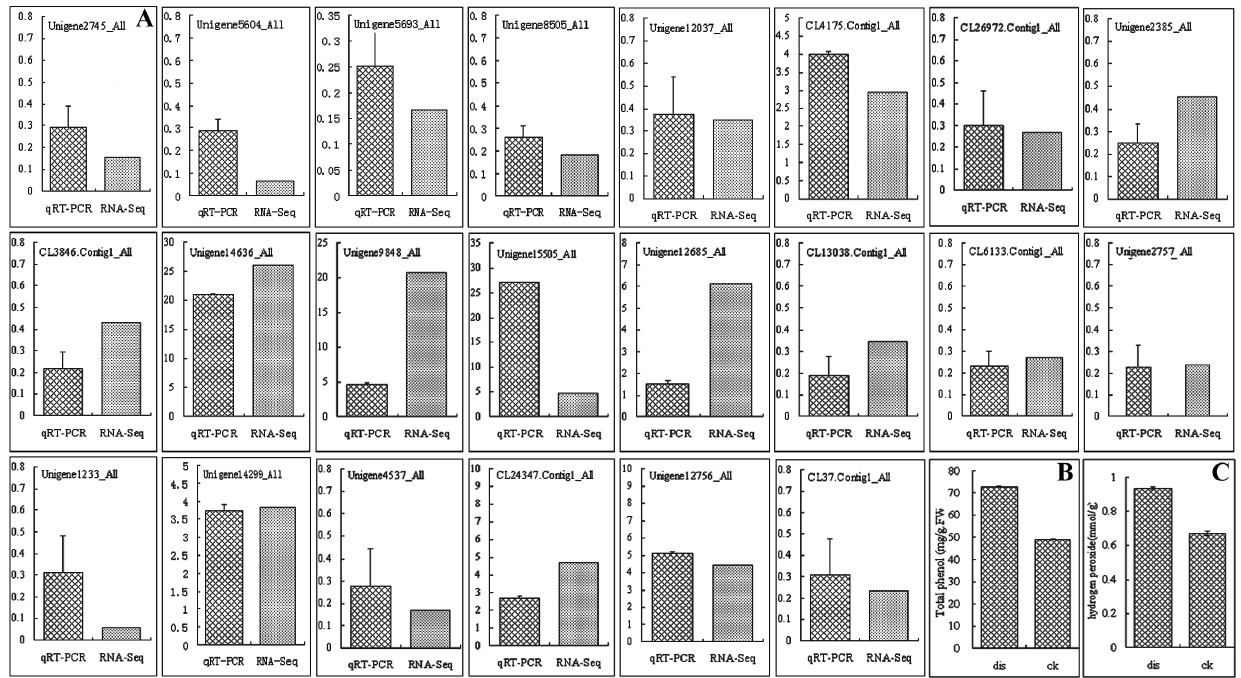
Figure 4. A: Real-time quantitative RT-PCR confirmation of the differentially expressed genes between normal control (CK) and surface brown spots disease (SBS, dis) fruit. B: The total phenolic content in CK and SBS fruit. C: H 2 O 2 content in CK and SBS fruit. The total phenolic was measured using the Folin-Ciocalteu method. Columns and bars represent the means and standard error (n=3), respectively.